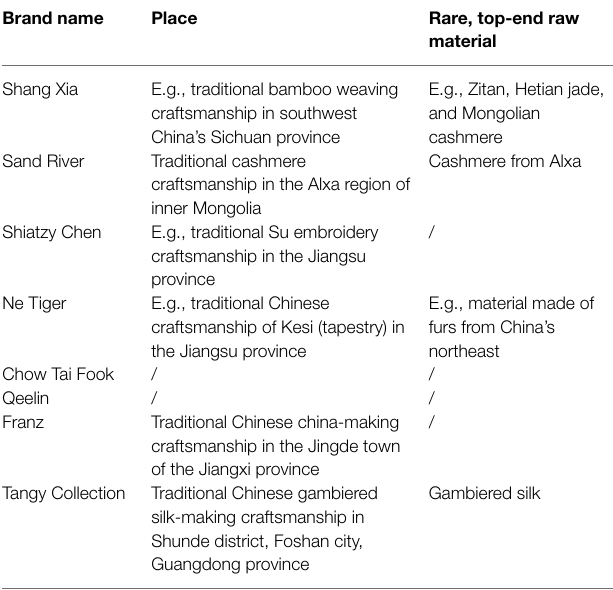
TABLE 3 | Use of places and raw materials to create authenticity, as summarized from